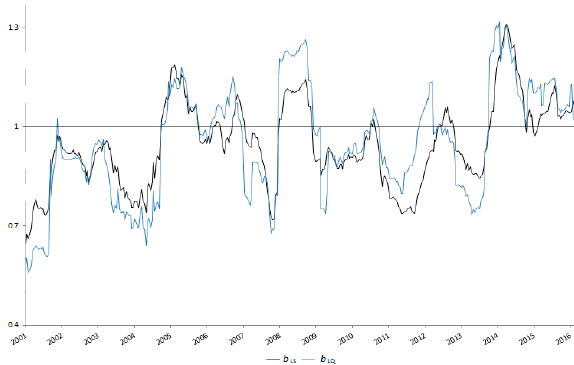
Figure 5. LS and LQ beta estimates for a sample asset.